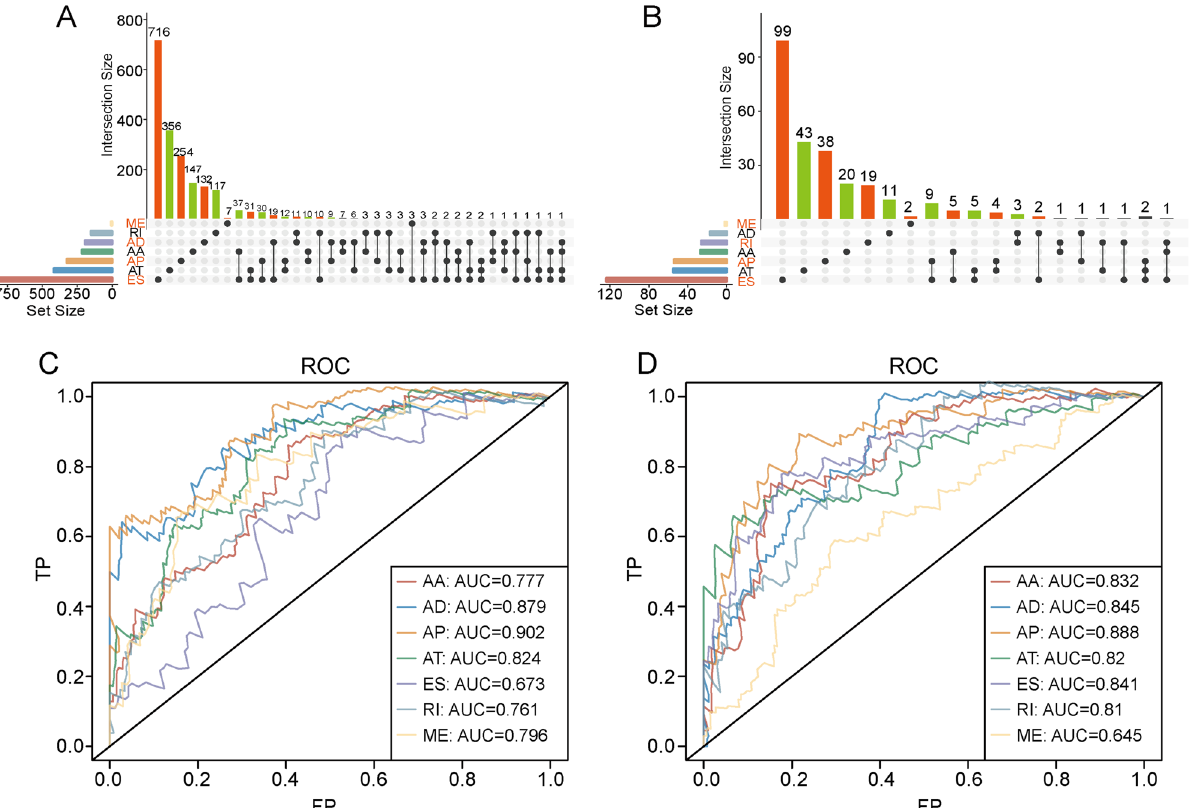
Figure 2. AS events are closely related to sarcoma prognoses. ( A ) The landscape of the seven subtypes of AS-associated genes that were significantly related to overall survival. ( B ) Distribution among the seven subtypes of AS-associated genes that were significantly related to survival genes. ( C ) AS-subtype area-under- the-curve (AUC) analyses for the classification of the top 15 AS-associated genes based on prognoses. ( D